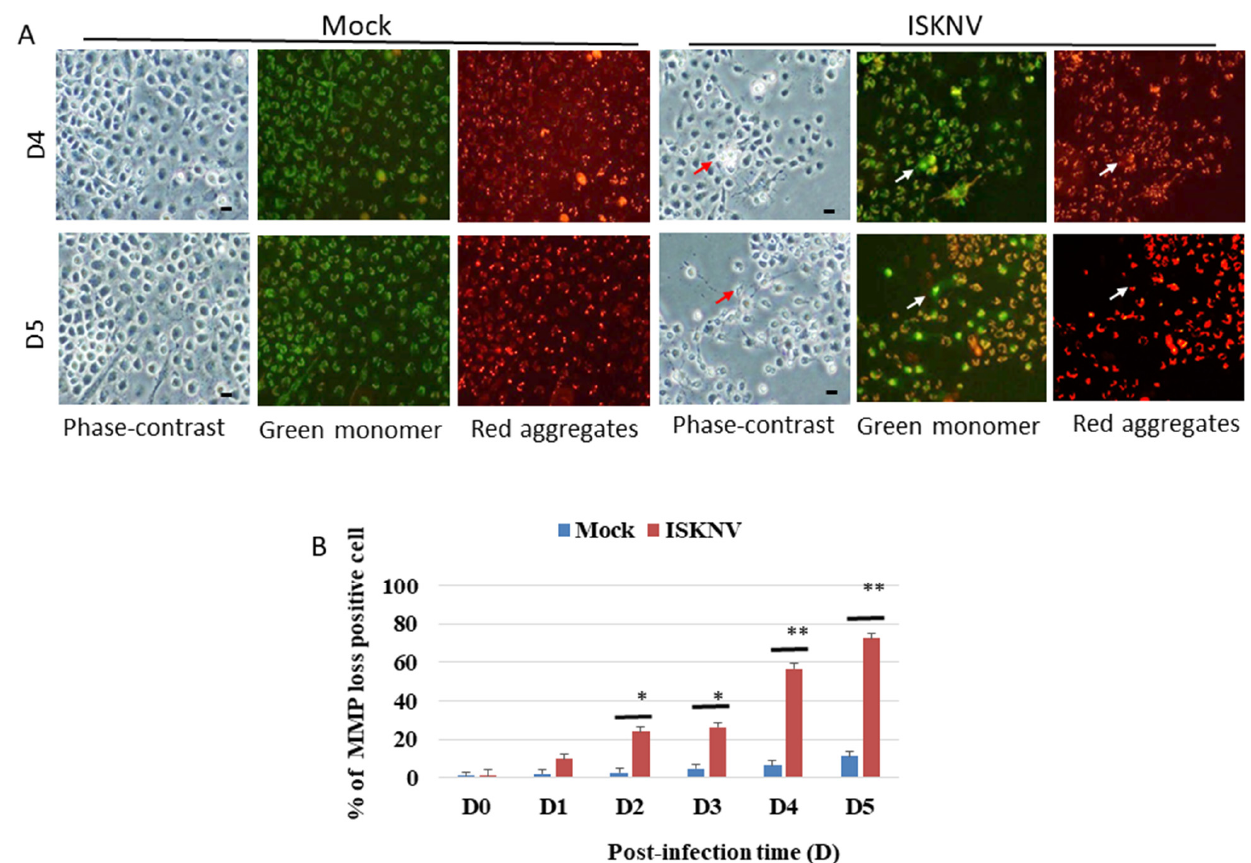
Figure 3. ISKNV infection can induce the loss of MMP in GF-1 cells. ( A ) Identification of ISKNV infection inducing MMP loss in GF-1 cells at D4 and D5 post-infection. Phase-contrast and fluorescence images for mock control group (left panels D4 and D5); green/red fluorescence images (middle panels/right panels) for MMP loss-positive cells. Phase-contrast (ISKNV-infected cells indicated by red arrows) and fluorescence images for ISKNV-infected group (left panels D4 and D5); green/red fluorescence images (middle panels/right panels) for MMP loss-positive cells, in which MMP loss cells are indicated by white arrows. Scale = 10 µm. ( B ) The ISKNV-induced losses of MMP in GF-1 cells were counted at D0, D1, D2, D3, D4, and D5 post-infection. The numbers of MMP-loss cells among each of the 200 cell samples were assessed in three individual experiments. Each point represents the mean MMP-loss cells of three independent experiments ± the standard error of the mean (SEM). The data were analyzed using either paired or unpaired Student’s t -tests, as appropriate. Statistical significance was defined as * p -values < 0.05; ** p -values < 0.01.